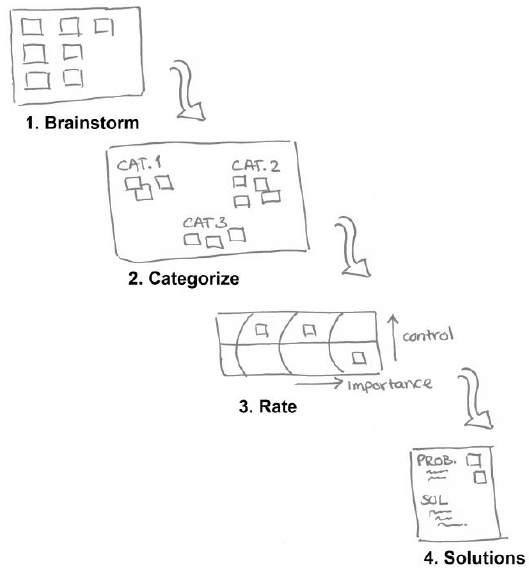
Figure 2. The steps of the workshop.